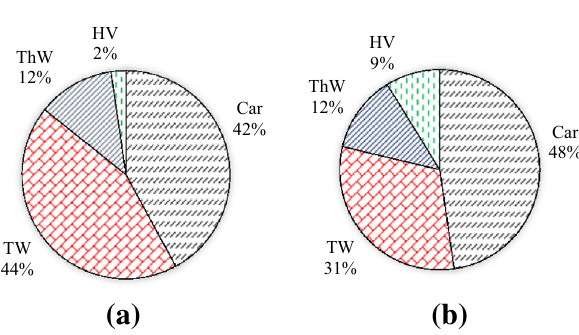
Fig. 2 Vehicle composition in terms of percentage: a Panchsheel Marg. b Ho-Chi-Minh Marg